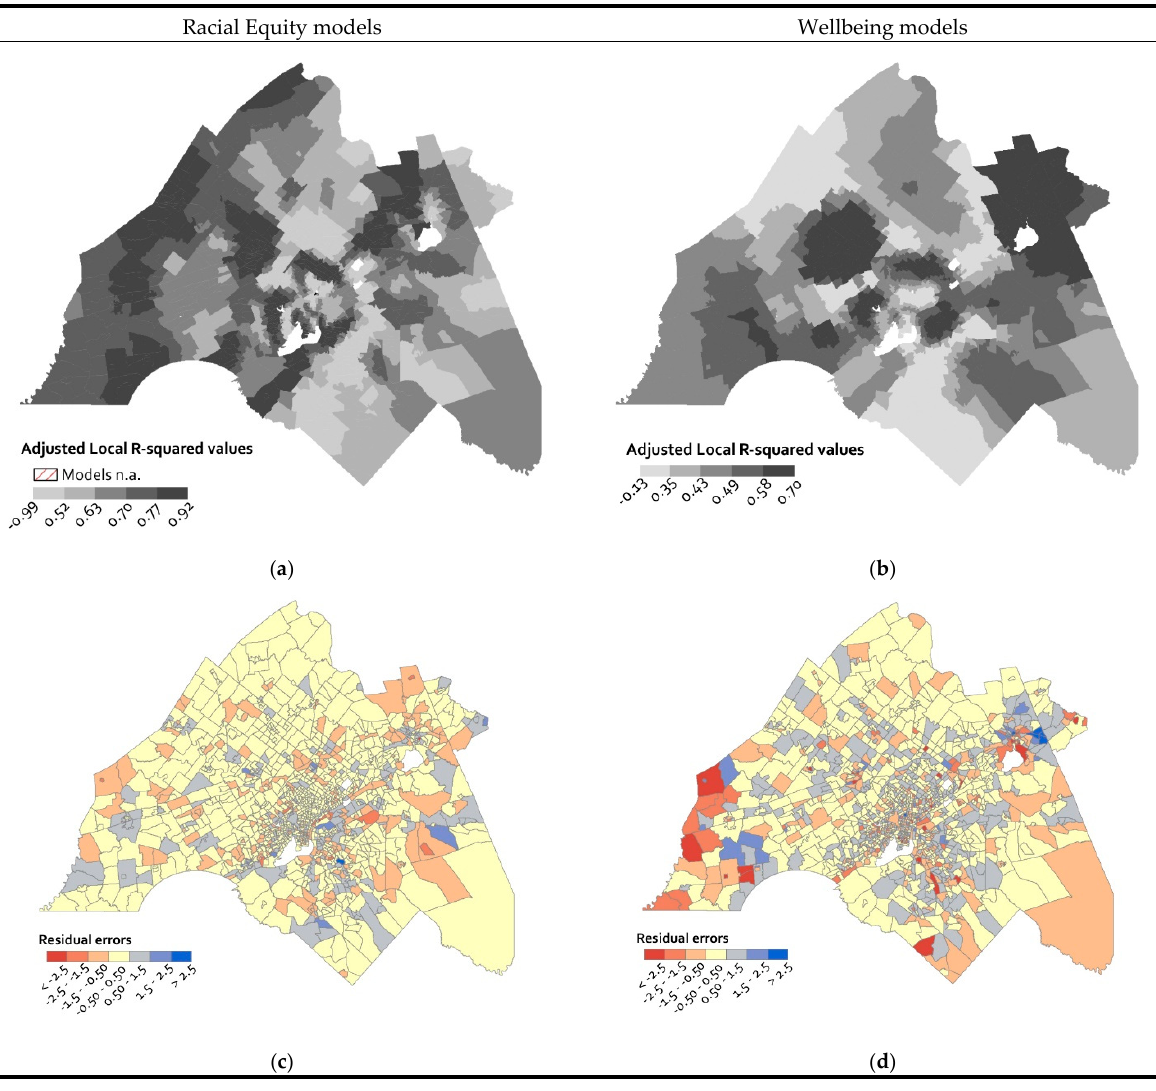
Figure 3. Local R2(adjusted) quintile maps of the GWR model for ( a ) Racial Equity and ( b ) Wellbeing indicators. Darker colors depict higher values and explanatory power of infrastructure predictors. Residual error standard deviation maps of ( c ) Racial Equity models and ( d ) Wellbeing show no significant clustering of the error terms.